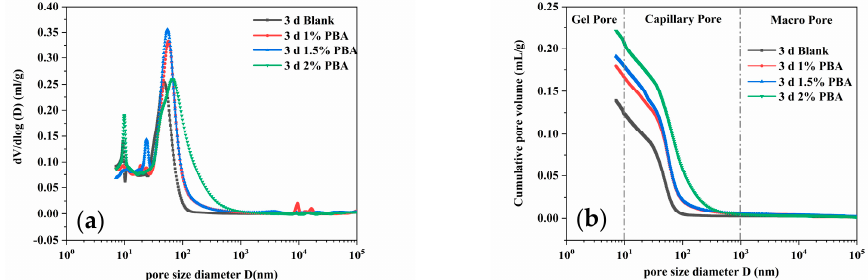
Figure 8. Pore structure of samples with di ff erent PBA content for 3 days: ( a ) pore size distribution and ( b ) cumulative porosity.